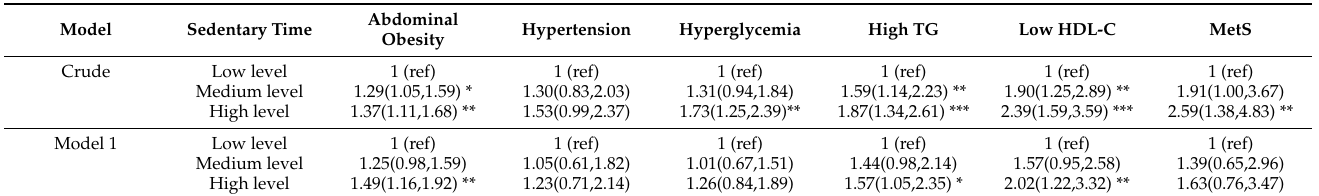
Table 3. Logistic regression analysis of sedentary behavior time, MetS, and its components of children aged 6–14 years (OR (95% CI of OR)).